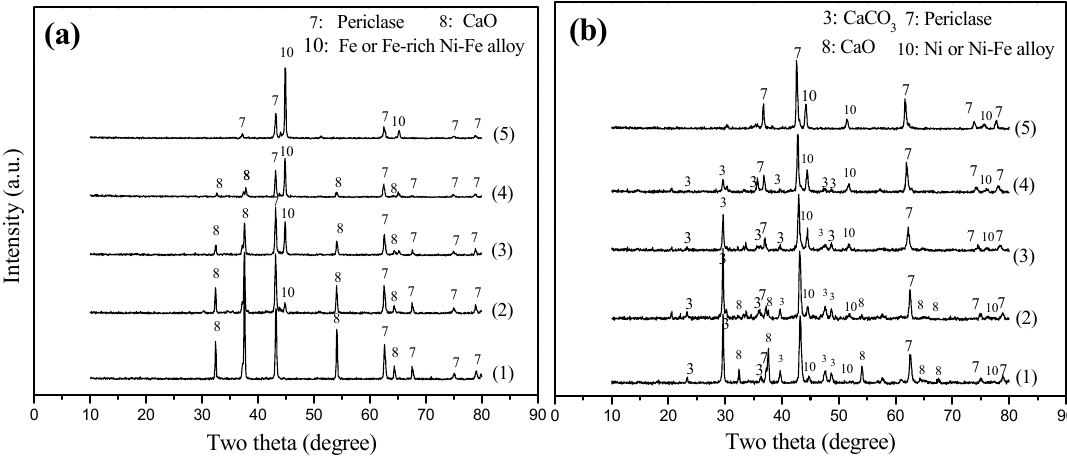
Figure 4. XRD patterns of Ni ‐ based catalysts of ( a ) reduced at 650 °C and ( b ) spent after ATR. (1) MNC 0.8 F 0.0 ; (2) MNC 0.7 F 0.1 ; (3) MNC 0.5 F 0.3 ; (4) MNC 0.3 F 0.5 ; and (5) MNC 0.0 F 0.8 .